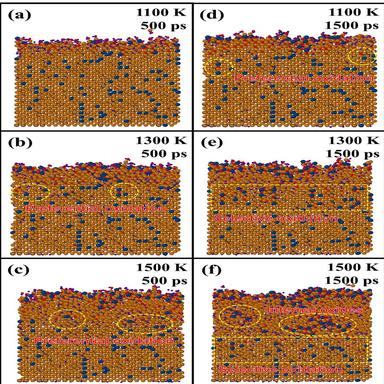
ReaxFF-MD corrosion simulation snapshots of Fe-9Cr steel under the pure SCW environment at 1100 K, 1300 K and 1500 K. Herein, yellow, cyan, red and blue balls represent iron, chromium, oxygen and hydrogen atoms, respectively. (For interpretation of the references to color in this figure legend, the reader is referred to the web version of this article.)